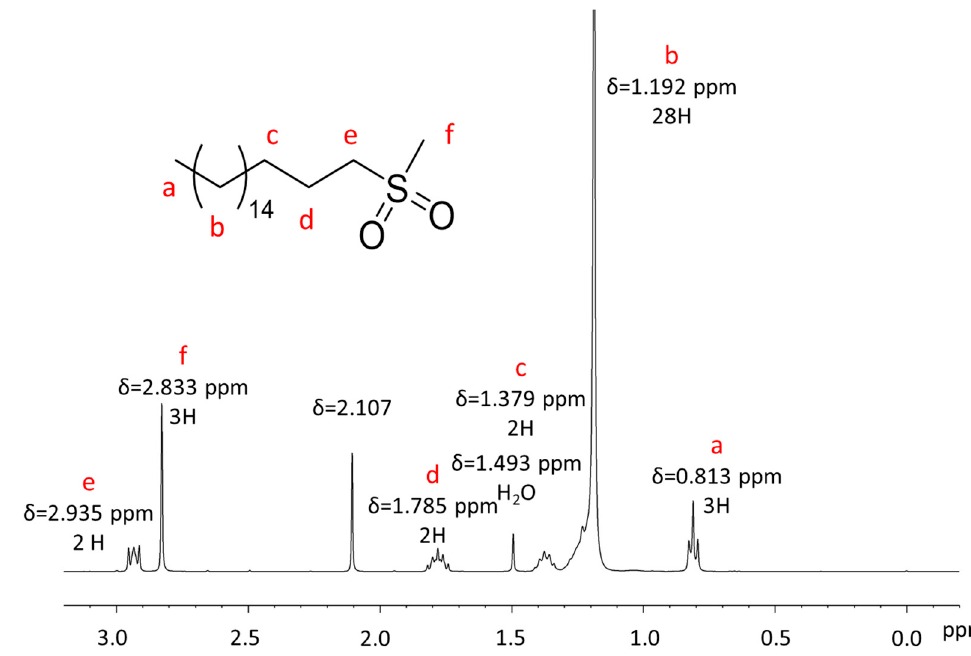
Figure A1. 1 H NMR of methylsulfanyloctadecane.